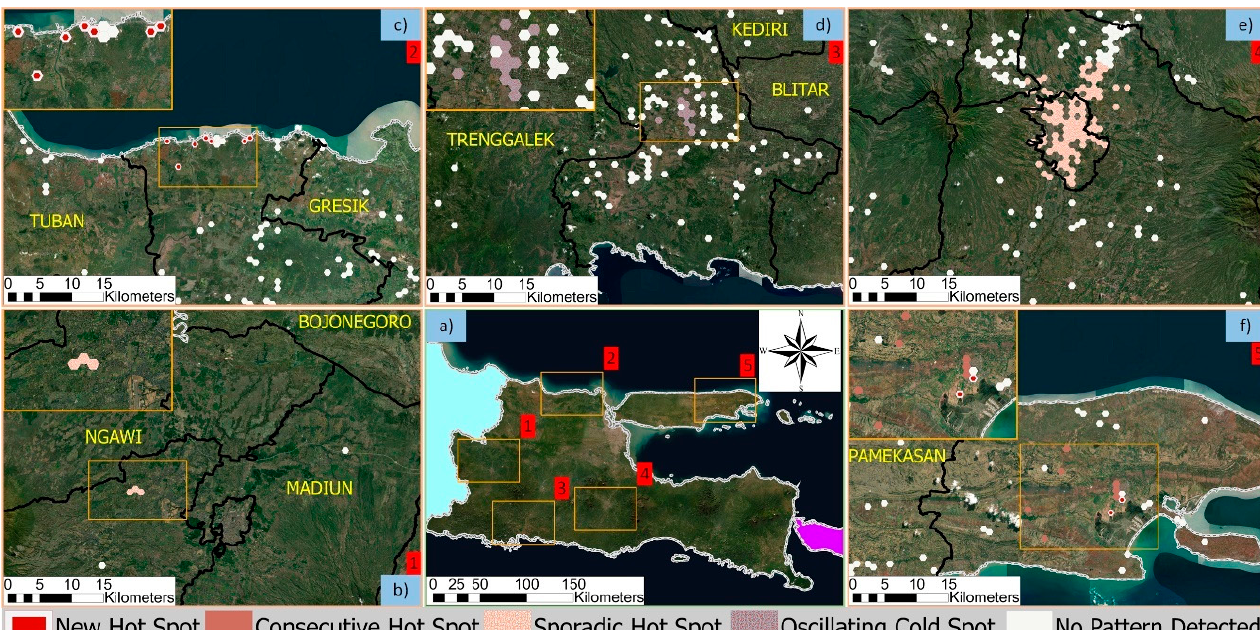
Figure 8. Hotspot/cold spot area detected in ( a ) five areas, such as ( b ) Magetan in April, ( c ) Lamongan in May, ( d ) Tulun- gagung in June, ( e ) Malang Raya, and ( f ) Sumenep that accumulated over a period of four months, respectively. Colors represent the degree of case severity (refer to Tables A1 and A2 for color information).